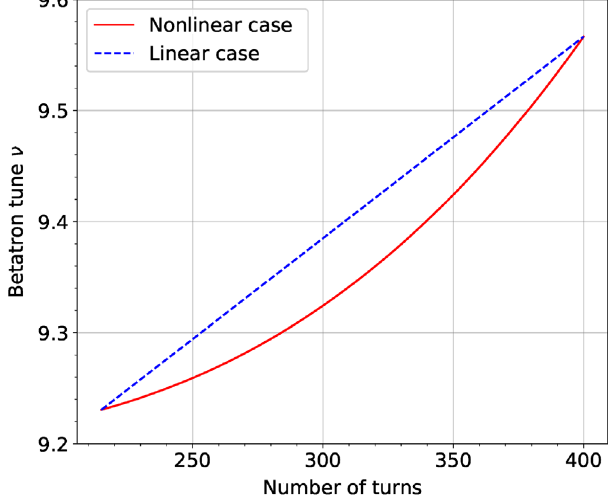
FIG. 7. Tune excursion from 215 to 400 turns. A red solid curve redraws Fig. 1, whereas a blue dashed line represents a linearized one.